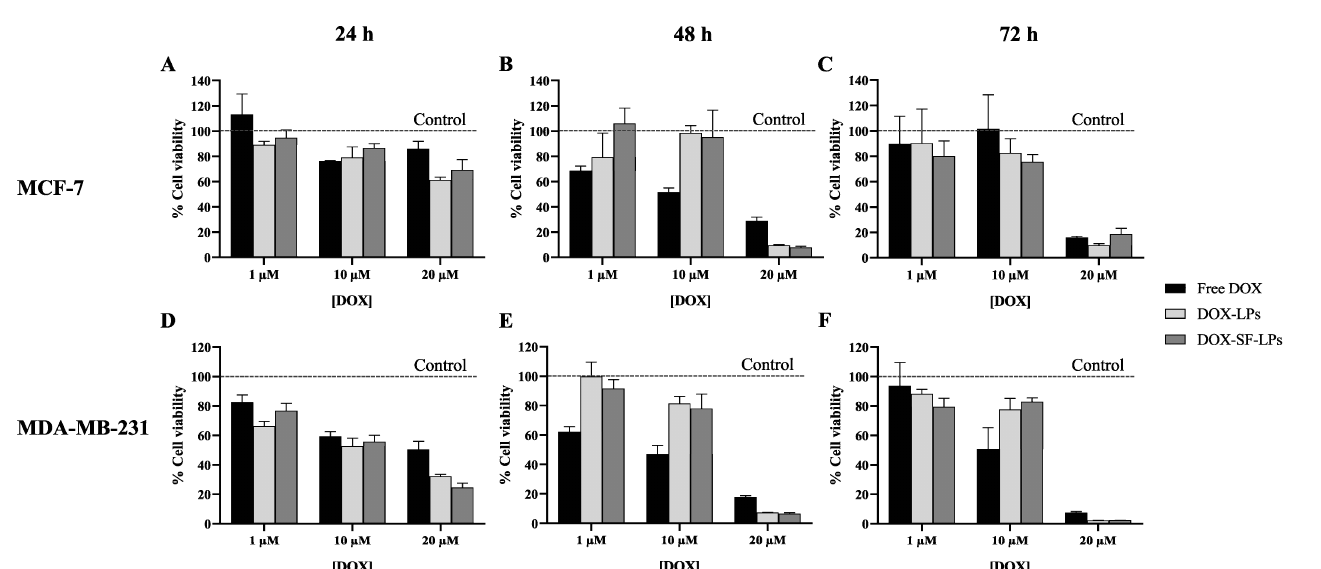
Figure 8. Cell viability of ( A – C ) MCF-7 and ( D – F ) MDA-MB-231 when exposed to DOX as a free drug and encapsulated in liposomes (DOX-LPs) or SF-coated liposomes (DOX-SF-LPs). SF-LPs were composed of soy PC:CH:SA (10:1:3) and 1% SF. The cells were treated with DOX in all forms at the final concentrations of 1, 10, and 20 μ M for 24 h, 48 h, and 72 h. The percentage of cell viability was determined using the MTT assay. The cell viability was normalized within the control (PBS) of each incubation period as indicated by dashed lines (100% cell viability). Data are presented as the mean ± SEM, n = 3.